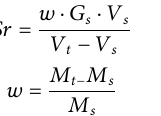
Frontiers in Energy